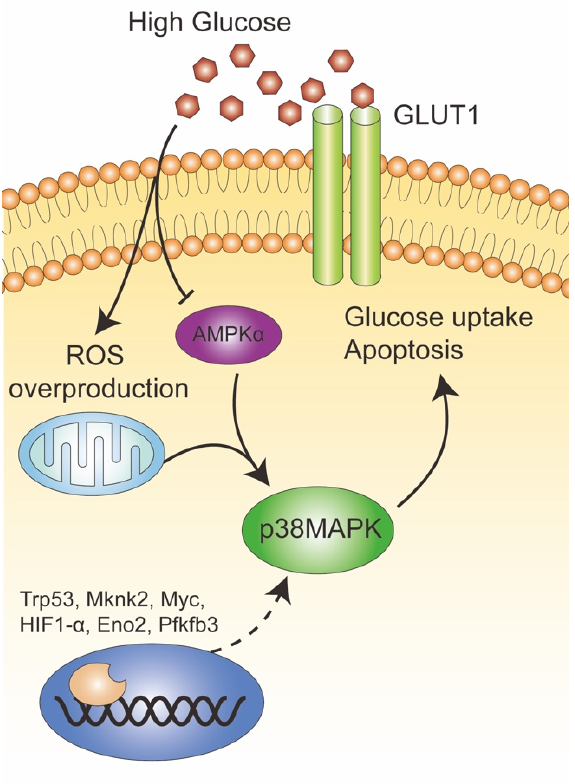
Figure 8. Schematic diagram: The mechanism of AMPKP α -p38MAPK signaling on GLUT1 regulation in trophoblast cells. AMPK α was inactivated, while p38MAPK and GLUT1 were upregulated in high-glucose-induced OS impairment accompanied by enhanced apoptosis. Potential molecules (Trp53, Mknk2, Myc, HIF1-α, Eno2, and Pfkfb3) may target p38MAPK and be involved in GLUT1 regulation. Solid arrow: established regulatory mechanism and dotted arrow: predicted regulation.